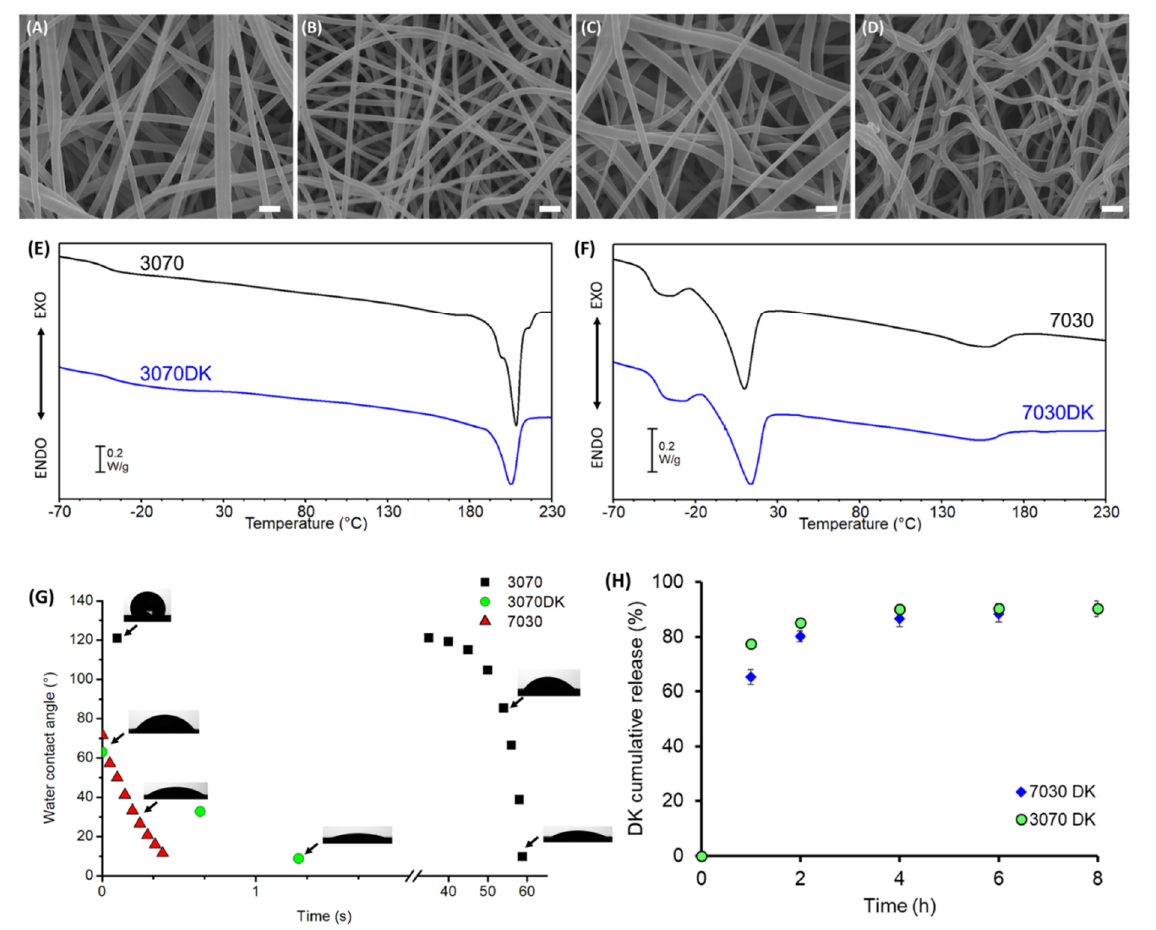
Figure 2. Characterization of the PEOT/PBT electrospun fibers. SEM images of the following: ( A ) 3070, ( B ) 3070DK, ( C ) 7030 and ( D ) 7030DK fibers; scale bar = 10 µ m. ( E ) DSC curves (second heating scans) of 3070 (black) and 3070DK (blue) mats. ( F ) DSC curves (second heating scans) of 7030 (black) and 7030DK (blue) mats. ( G ) Water contact angle measurements over time for 3070 (black square), 3070DK (green circle) and 7030 (red triangle) mats. ( H ) DK cumulative release profile over time for 3070DK (green circle) and 7030DK (blue diamond) electrospun fabrics.